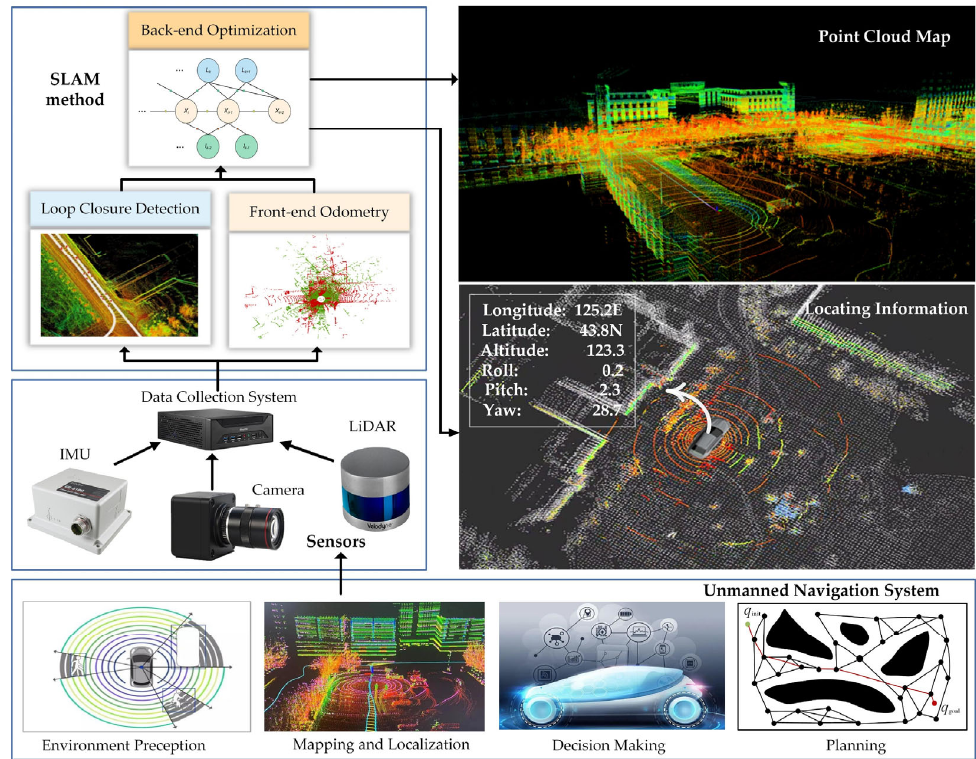
Figure 1. The schematic diagram of SLAM method in unmanned navigation system.